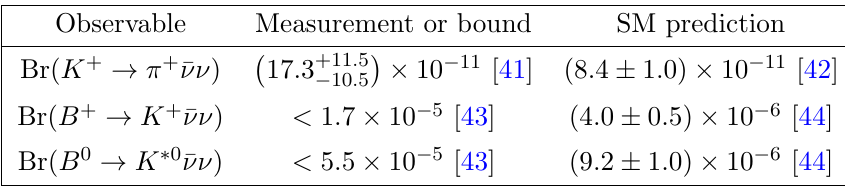
Table 2. Measurements and experimental bounds on the branching ratios of semi-invisible meson decays, and their SM predictions. Bounds are reported at 90% con(cid:12)dence level. missing energy. The processes K (cid:25) (cid:22) (cid:23)(cid:23) and B K ( (cid:3) ) (cid:22) (cid:23)(cid:23) are suppressed in the SM (see ! ! table 2), therefore strong constraints on (cid:20) arise from these